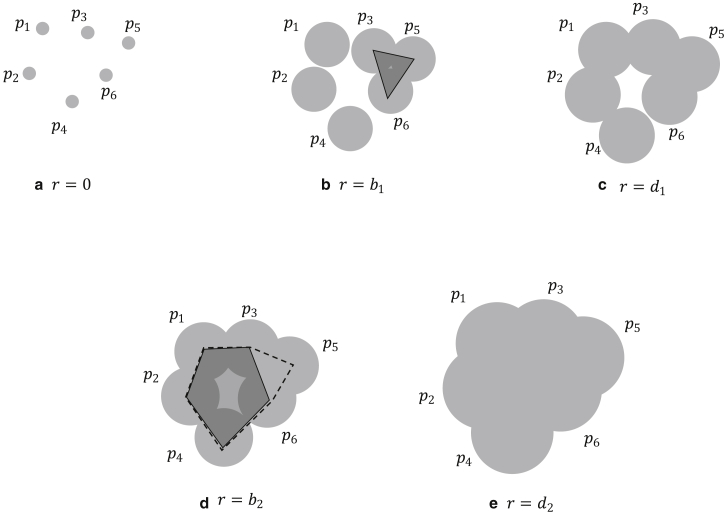
Example of PH analysis. If the radii of the balls are 0, then all atoms are disconnected (a). As we increase the size, the balls coalesce. At r = b1, we obtain a loop surrounded by three edges: (p3p5), (p3p6), and (p5p6) (b). This loop is destroyed when we increase the size of the balls to r = d1 (c). If we increase r further, a new loop appears (d). In this case, we can take several sets of edges that surround the empty space, depicted as solid and dashed lines. In this case, the volume-optimal cycle is (p1p2), (p2p4), (p4p6), (p6p3), and (p3p1), depicted by solid lines. This loop is destroyed at r = d2 (e).